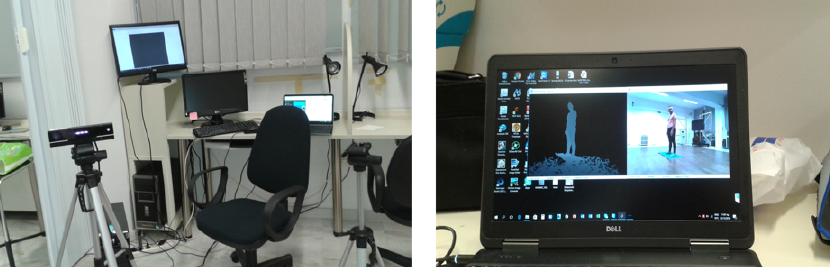
Figure 2. Kinect workstation.